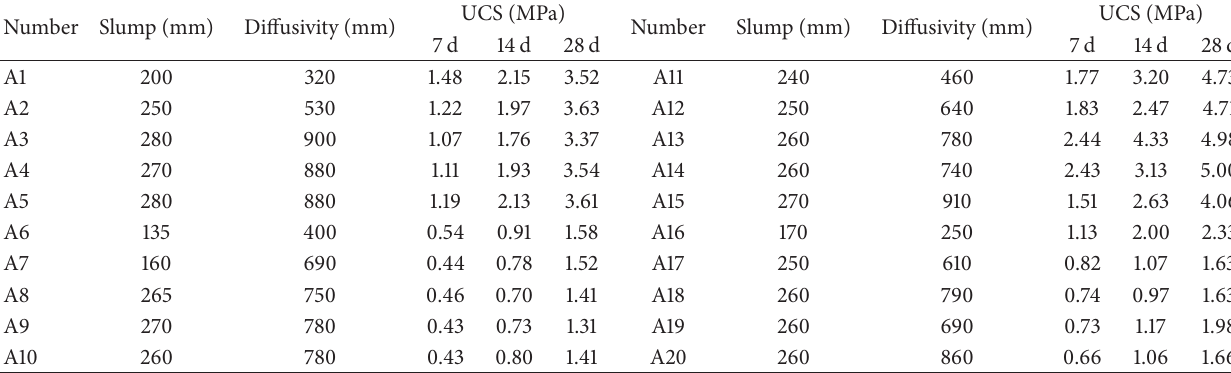
Table 3: The results of the second experiment.